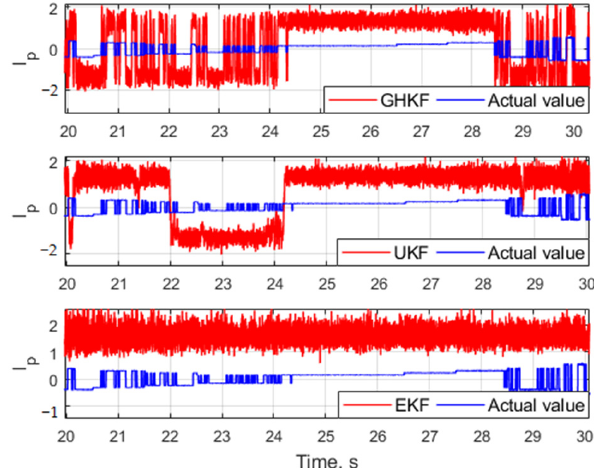
/ C N = 26 dB-Hz. Figure 4. Data navigation bits from 20 to 30 s, at C / N 0 = 26 0